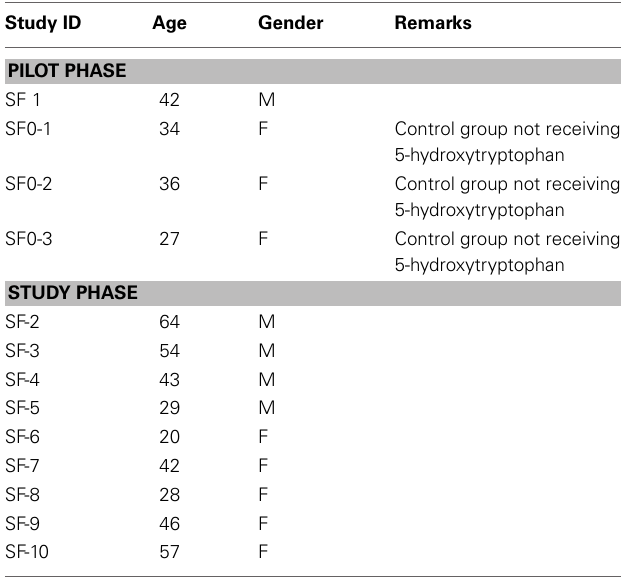
Table 1 | Study subjects characteristics.